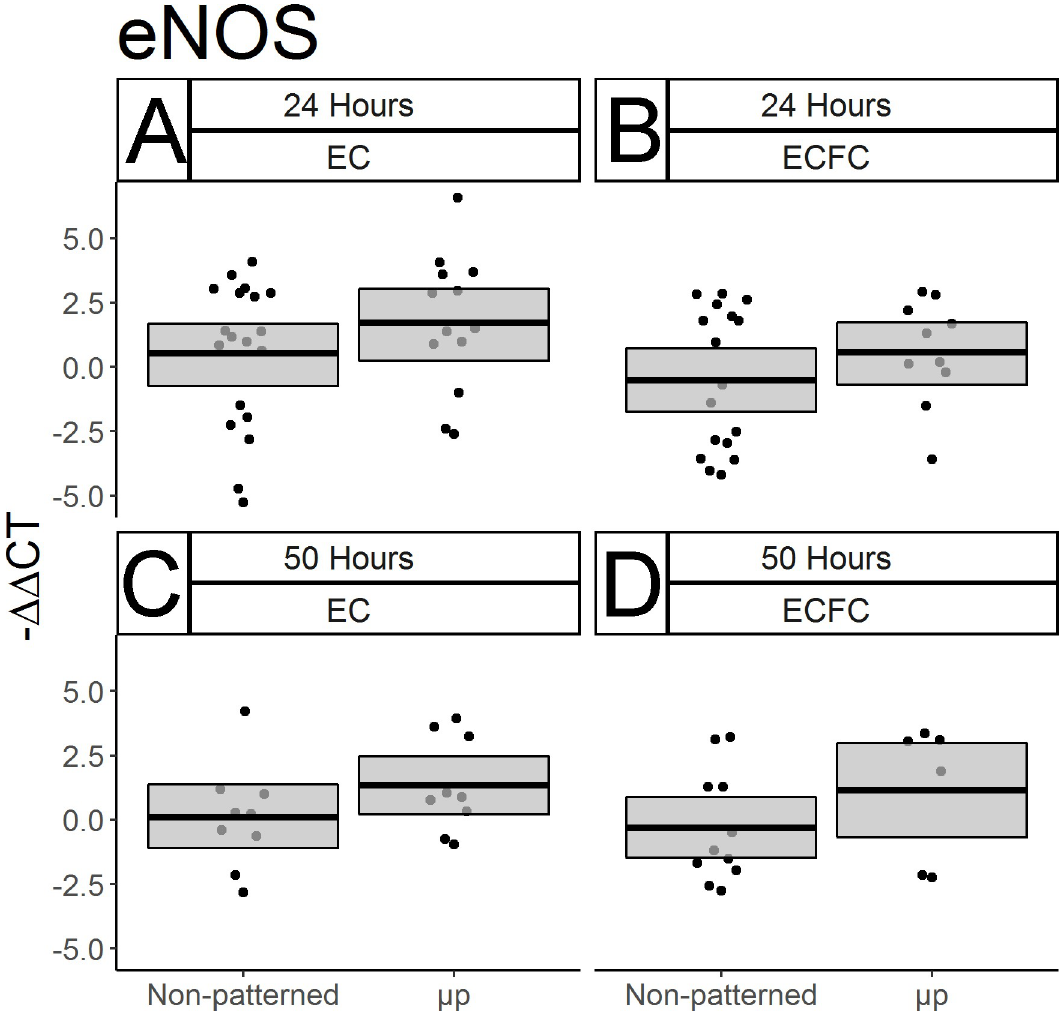
Fig 5. ECFC eNOS gene expression after micropatterning. qPCR was used to measure EC and ECFC gene expression of eNOS with and without micropatterning after 24 and 50 hours of culture. Results are displayed as– ΔΔ CT. Box limits represent bootstrapped 95% confidence interval. Each point represents one biological replicate. In both cell types, and at both time points measured, no statistically significant differences in eNOS expression were seen in response to micropatterning. (A) ECs after 24 hours. (B) ECFCs after 24 hours. (C) ECs after 50 hours, (D) ECFCs after 50 hours.